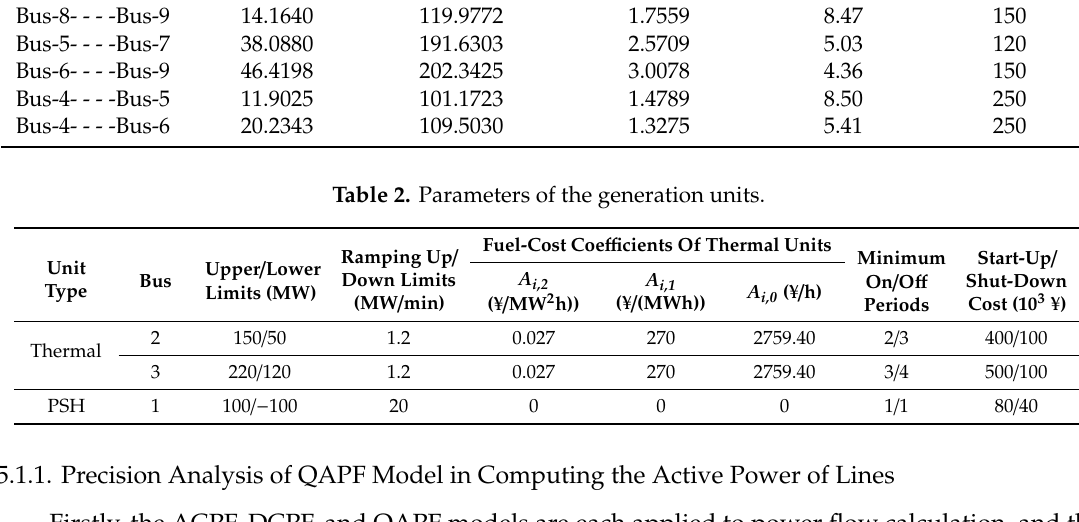
Table 3. Results by different power flow models.